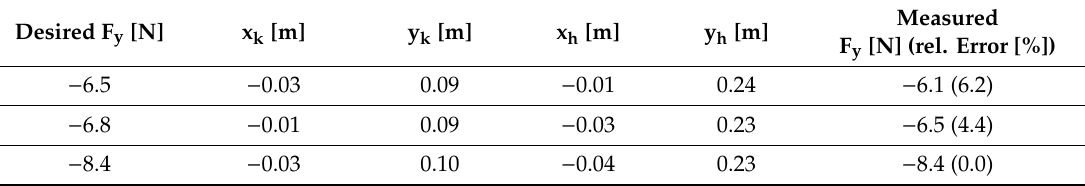
Table 2. Pulley position that provides desired vertical force and measured